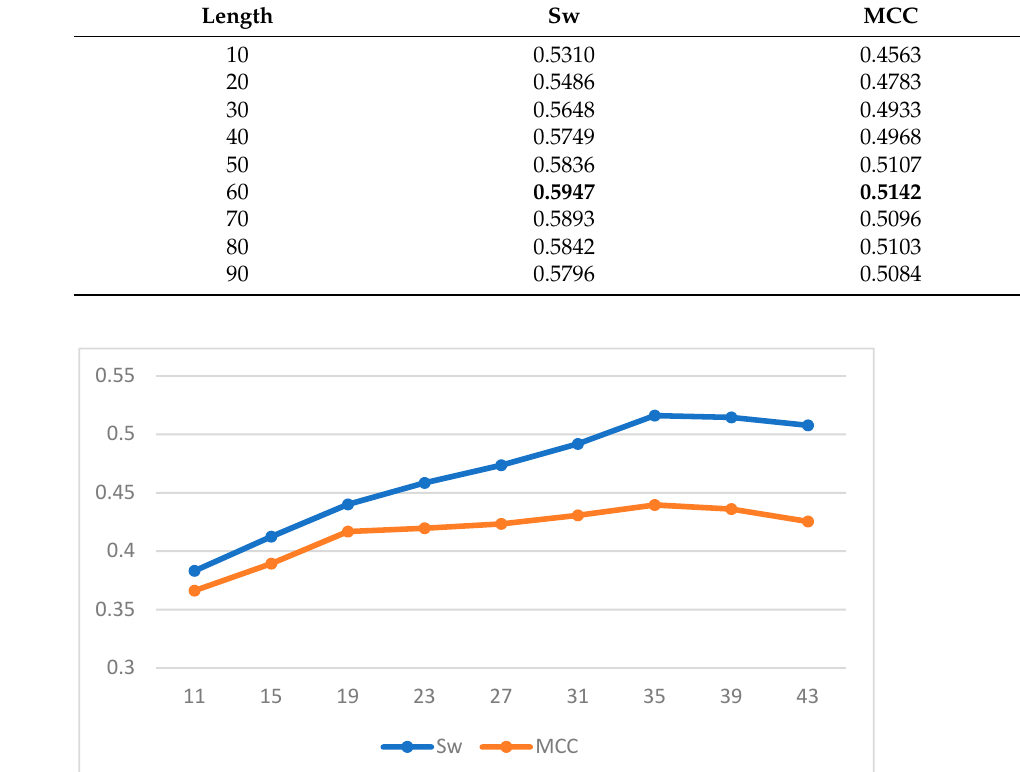
Figure 3. Effect of different window length on prediction performance of SVM.